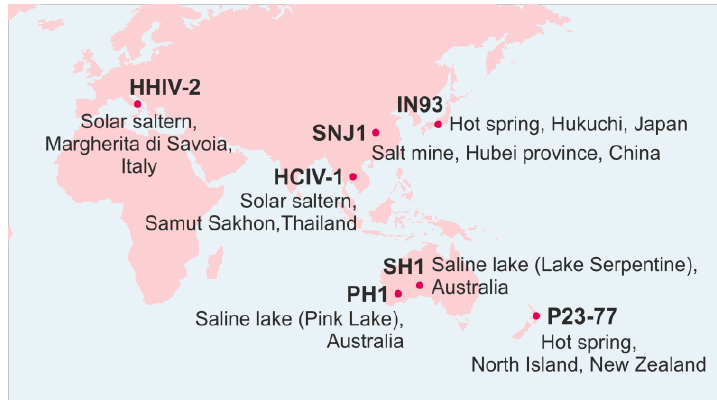
Figure 1. Sphaerolipovirus isolation locations. Map source: Freepic [54].